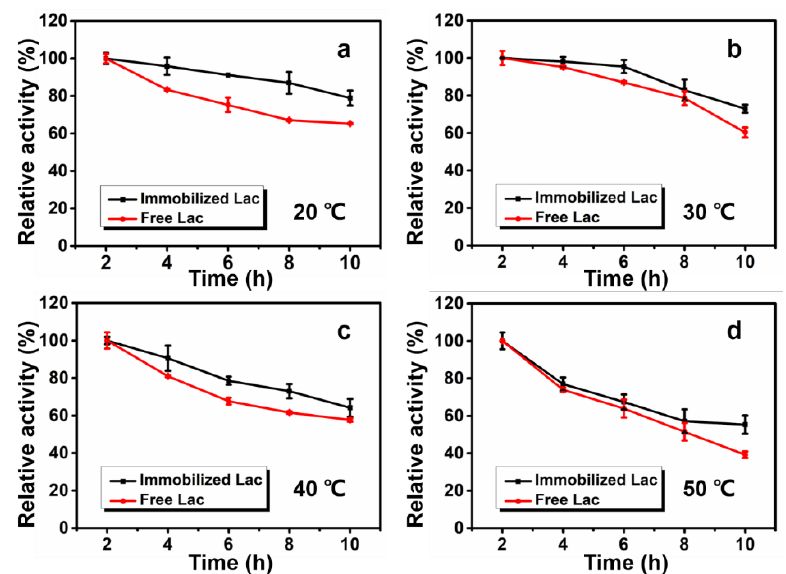
Figure 4. Thermal stability of free and immobilized Lac at: ( a ) 20 °C, ( b ) 30 °C, ( c ) 40 °C and ( d ) 50 °C.